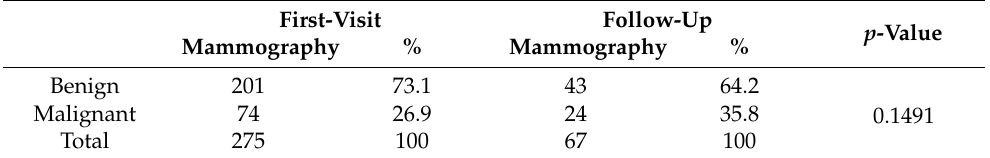
Table 2. The surgical biopsy results of examinees with positive mammography